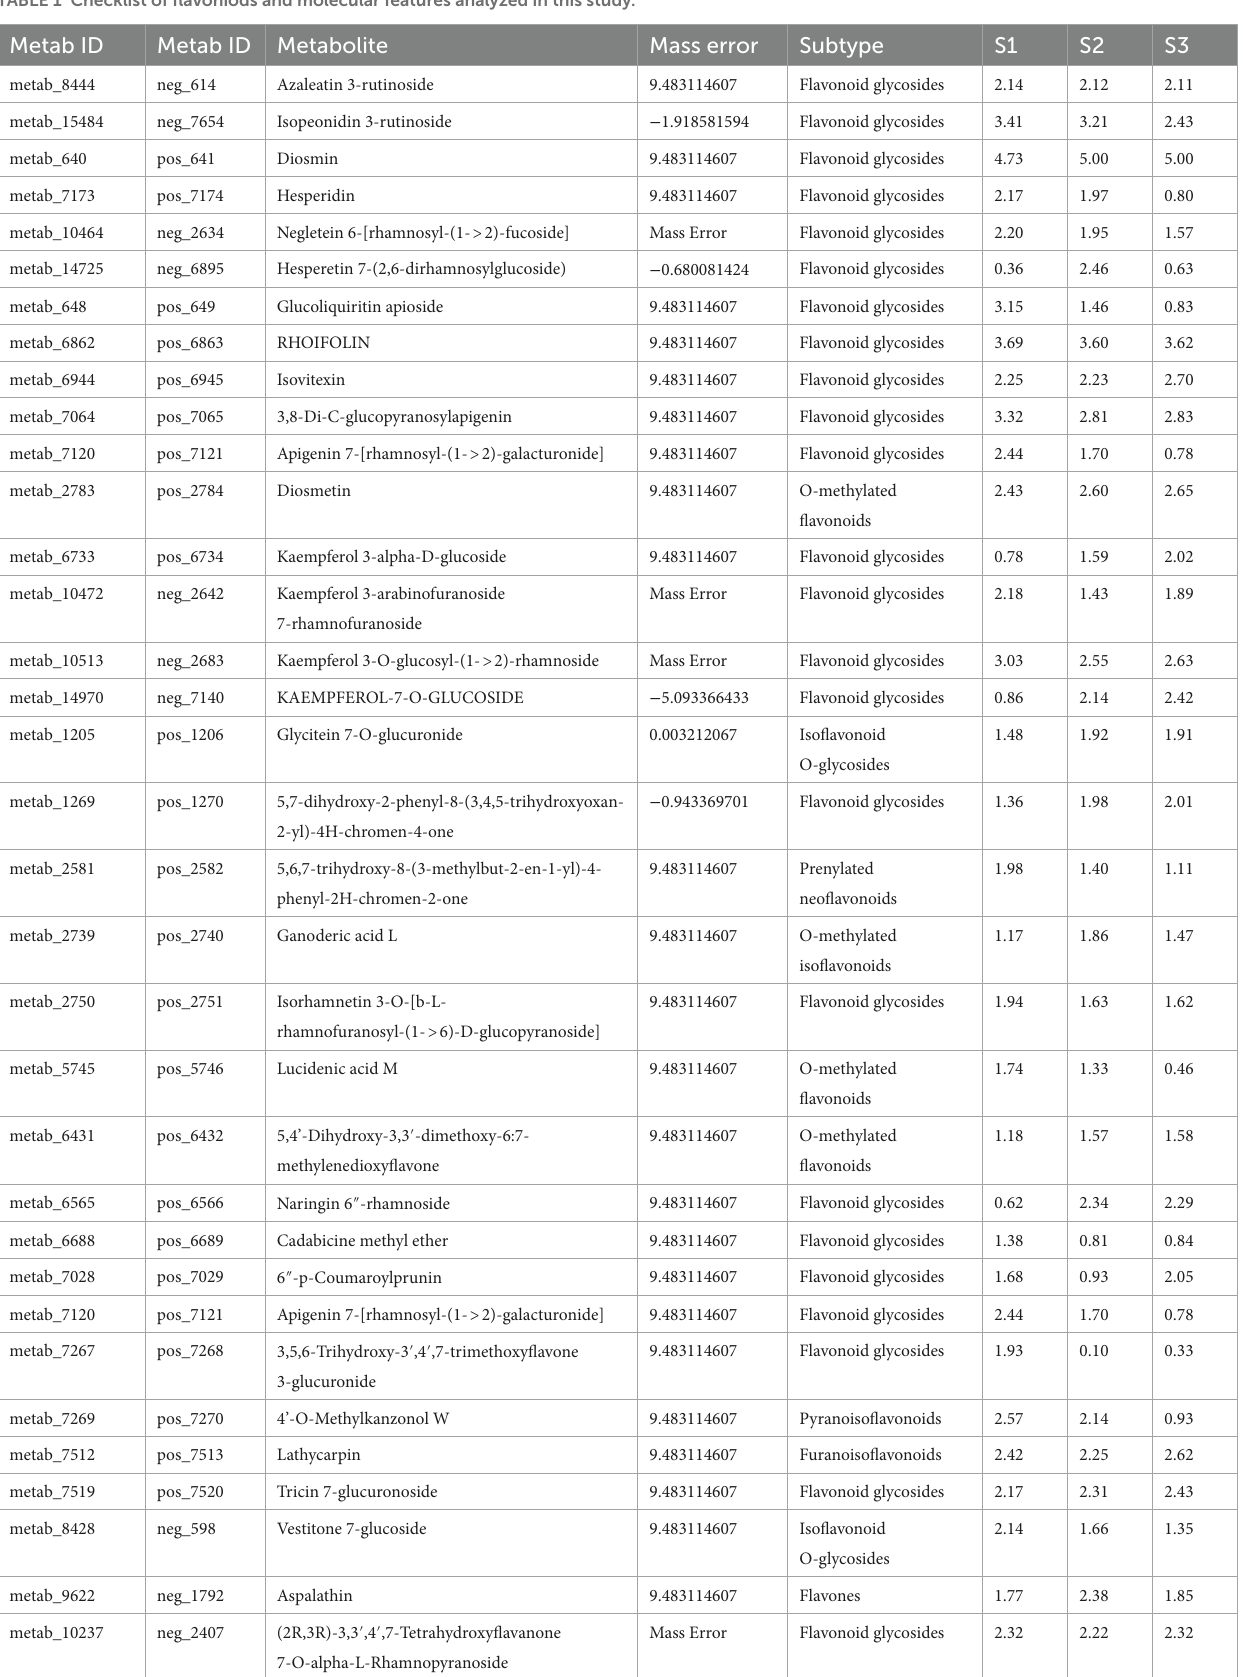
TABLE 1 Checklist of flavoniods and molecular features analyzed in this